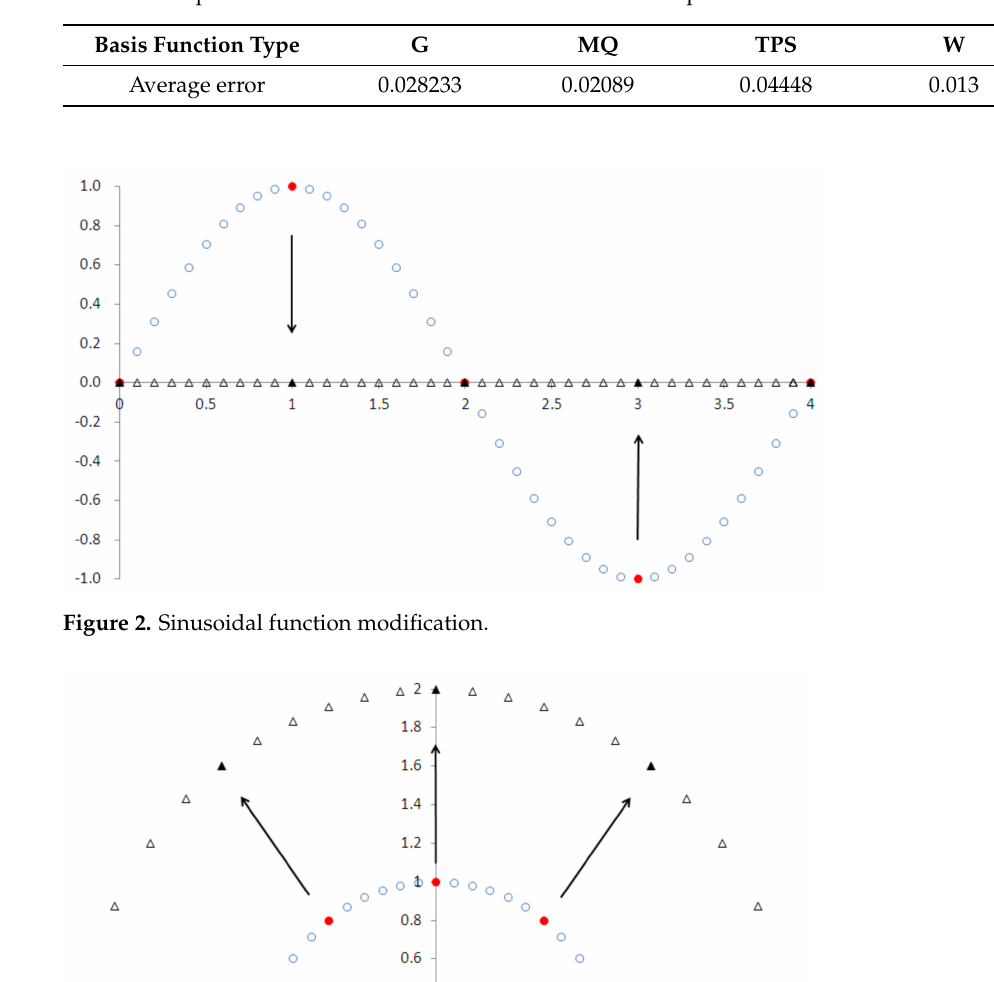
Table 3. Comparison of the basis functions in terms of the interpolation error.